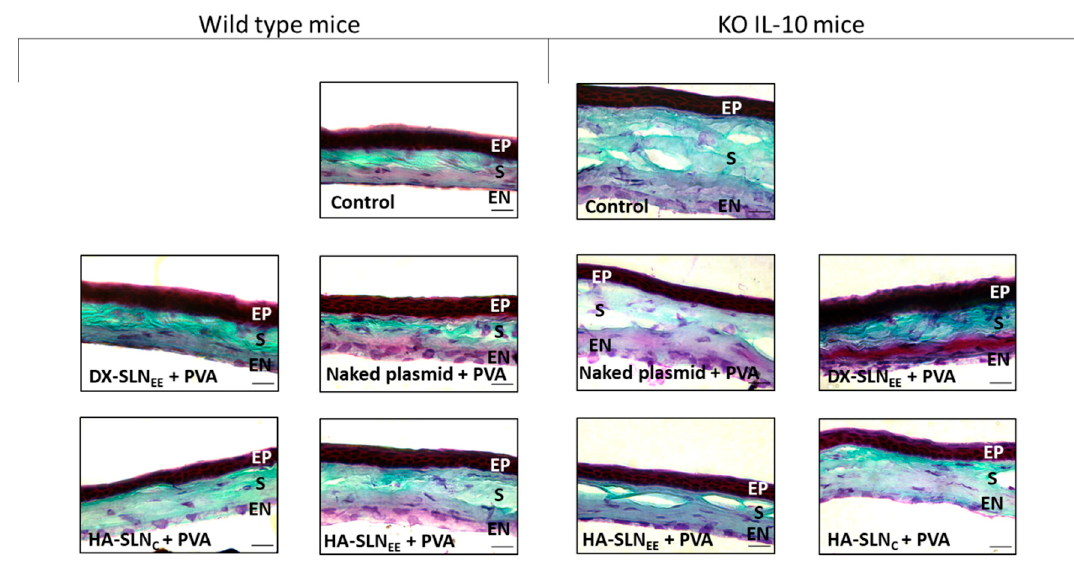
Figure 9. Microscopic images of wild type and IL-10 KO mice corneas stained by Masson’s trichrome technique. (60×) Scale bar: 20 µm. Green: collagen. Red: cell cytoplasm. Dark brown: cell nuclei. EP: epithelium, S: stroma, EN: endothelium; DX: dextran; SLN: solid lipid nanoparticle; PVA: polyvinyl alcohol; HA: hyaluronic acid; KO: knock out; IL-10: interleukin-10.